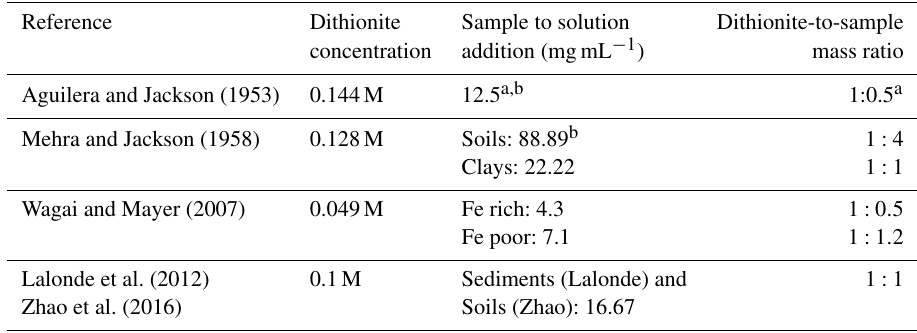
Table 1. Comparison of dithionite strength to sample mass in iterations of the CBD method applied to soils and sediments. Reference